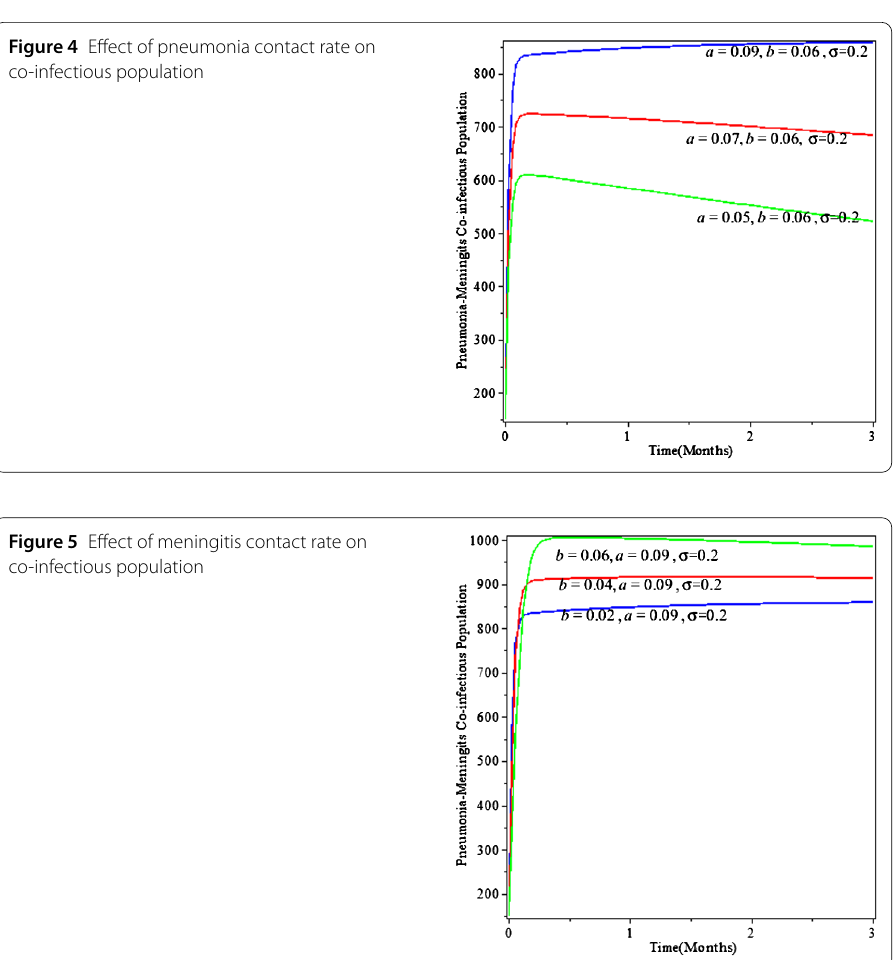
Figure 5 Effect of meningitis contact rate on co-infectious